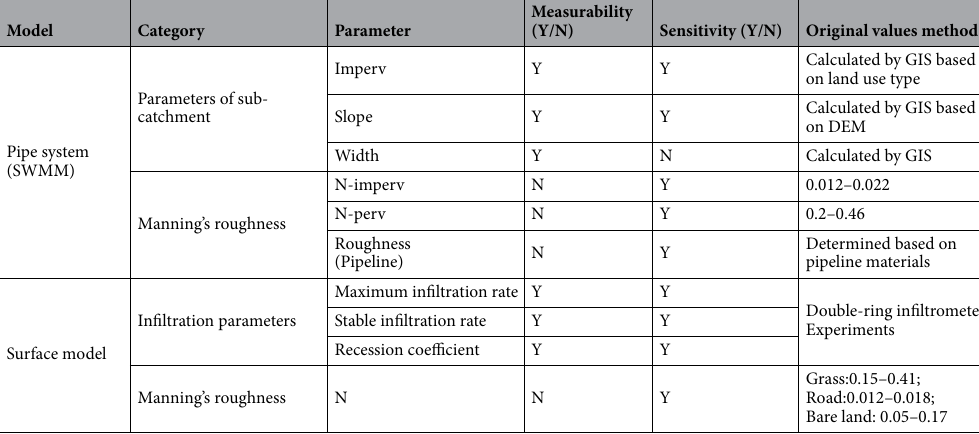
Table 3. Characteristics of model parameters.